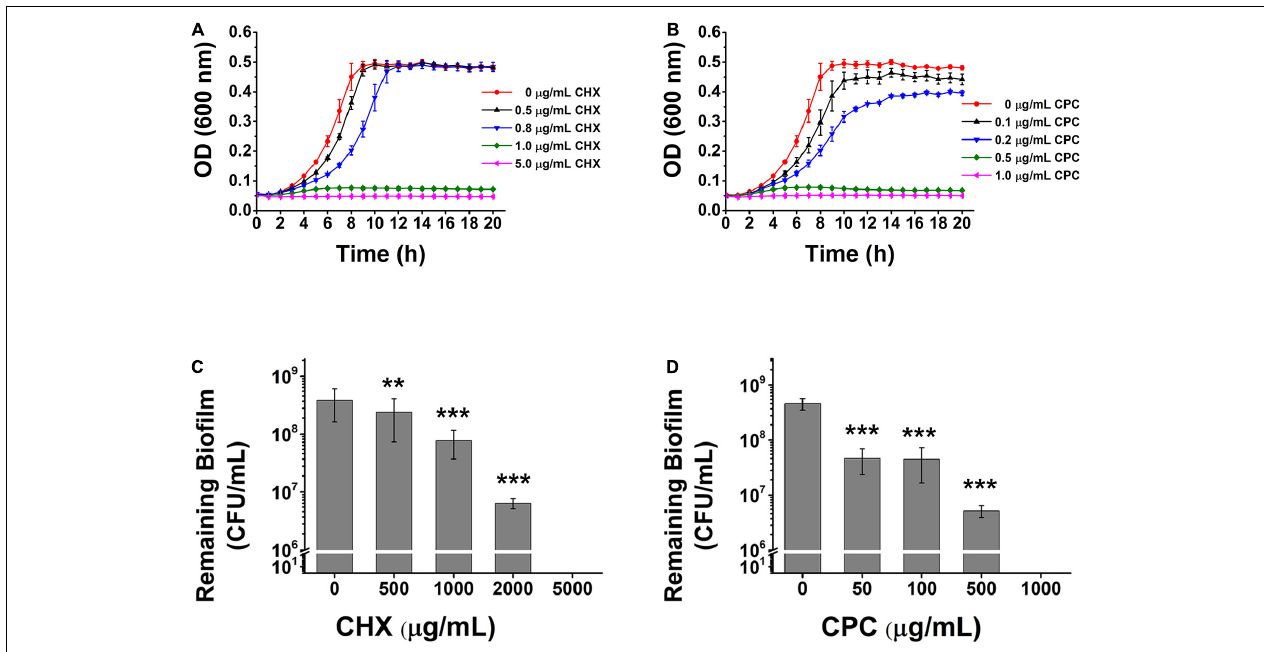
FIGURE 1 | The effects of CHX and CPC on S. mutans planktonic cells or biofilm. The planktonic cell growth curve and viable cells remaining in biofilms after treatment were tested. (A,B) The growth curves of S. mutans in BHI media containing different concentrations of CHX (A) or CPC (B) . (C,D) CFU enumeration for remaining viable cells in biofilms treated with CHX (C) or CPC (D) . Means ± SD from at least three independent experiments with technical triplicates are shown. Student’s t -test by SPSS 15 was used for data analysis. A p -value < 0.05 was considered statistically significant. ** p < 0.01; *** p <